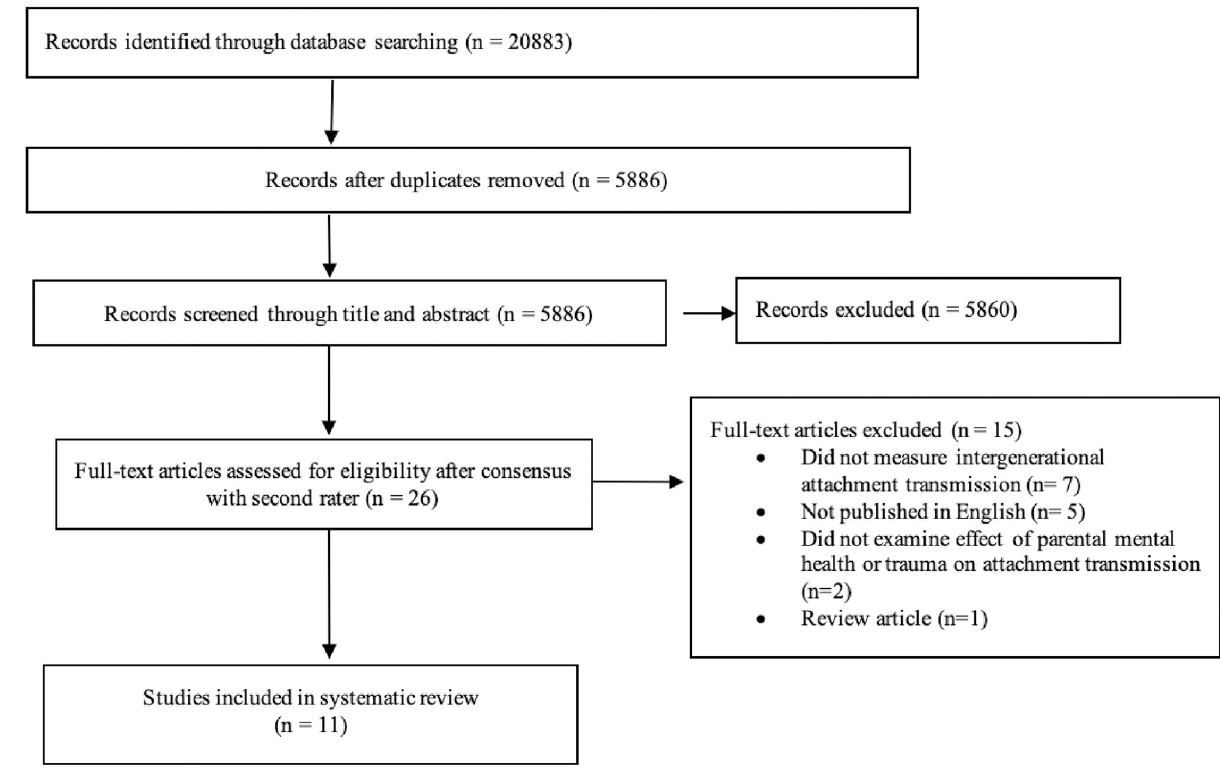
Fig 3. PRISMA flowchart for study identification and selection